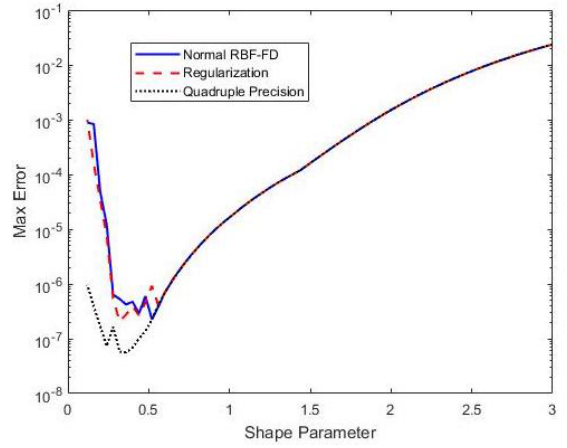
Figure 5. The graphs of max error of the RBF-FD method with regularization and extended precision strategies, compared to the normal RBF-FD